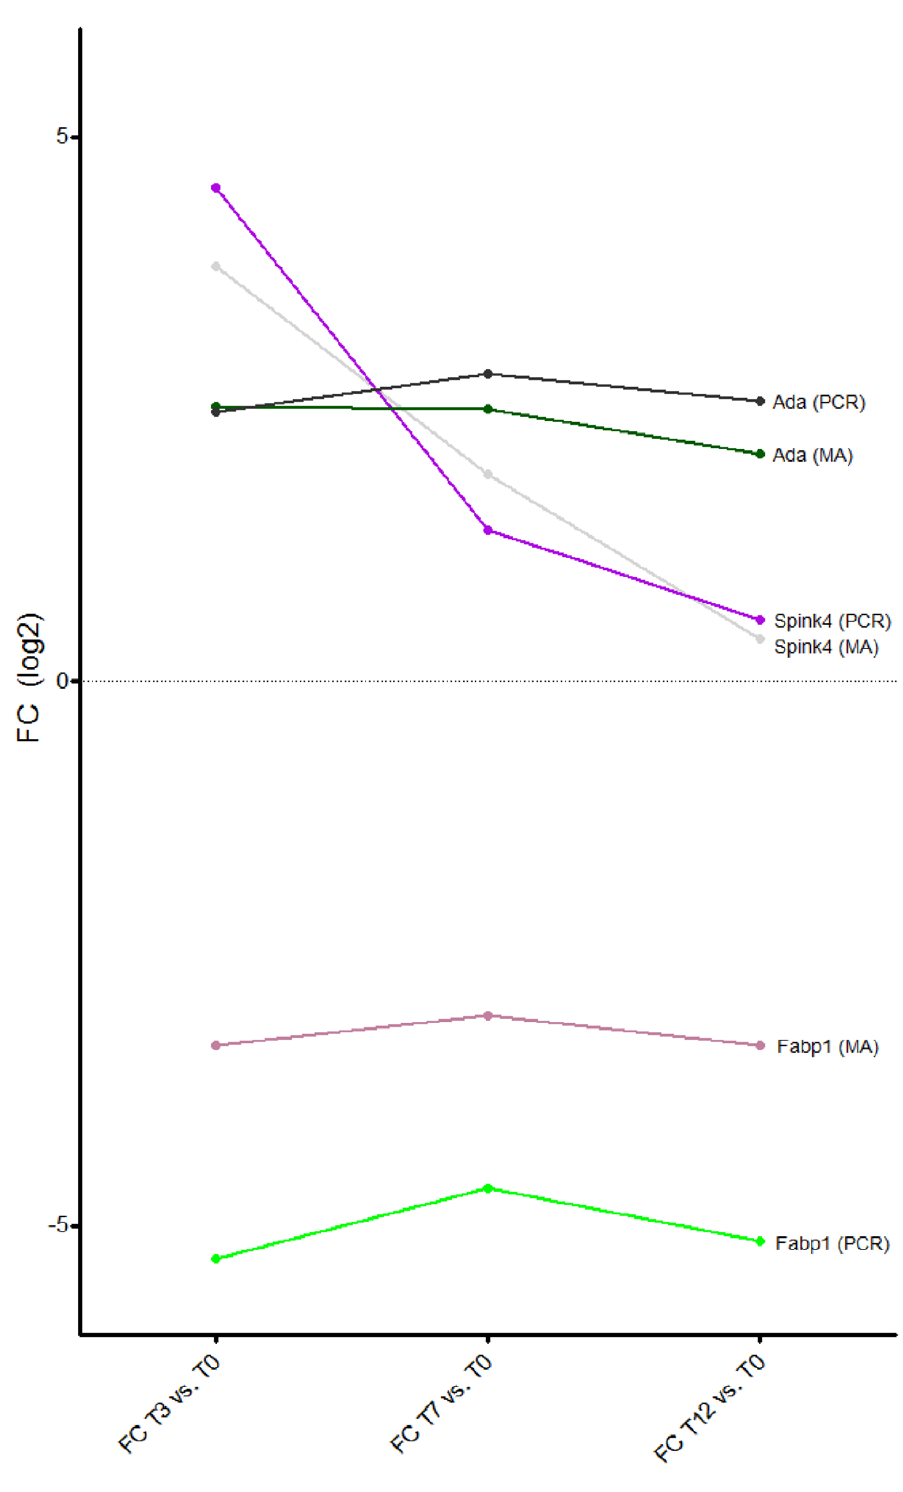
Figure 9. Graph displaying confirmatory PCR. Graph displaying FC for T3 vs. T0 , T7 vs. T0 and T12 vs. T0 for SPINK4, ADA and FABP1 for both microarray (MA) and confirmatory PCR. FC is log2 transformed for illustrative purposes. All p-values are highly significant.